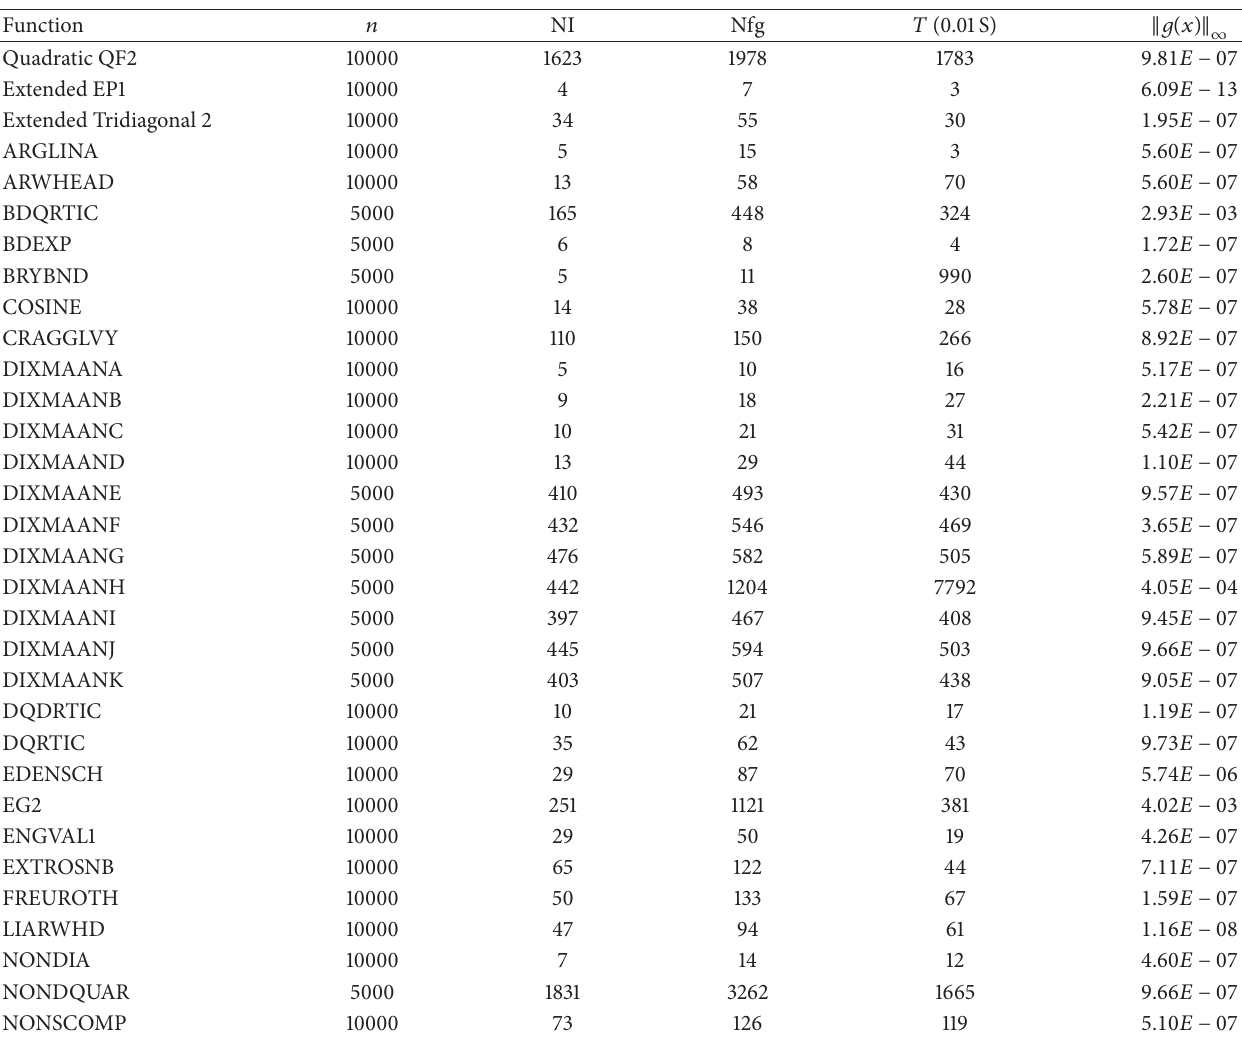
Table 4: Numerical results for DS-HSDY